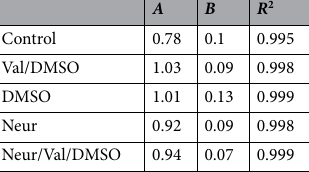
Table 1. Gradient ( A ), intercept ( B ) and quality of fit ( R 2 ) of linear fits to the variation in σ cyto with σ med for the five conditions examined